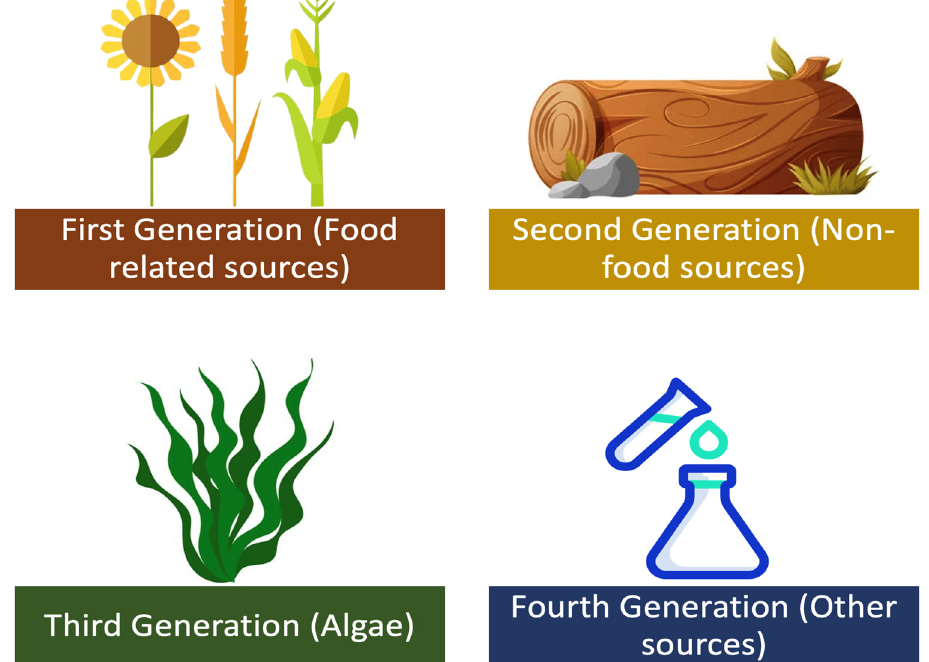
Figure 2. Generations of biofuels.